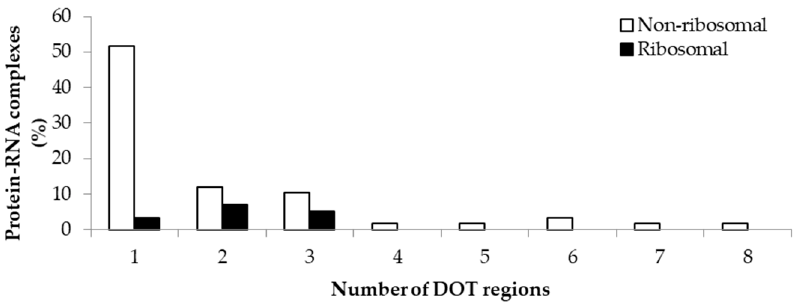
Figure 1. Percentage of protein–RNA complexes containing different number of DOT regions.